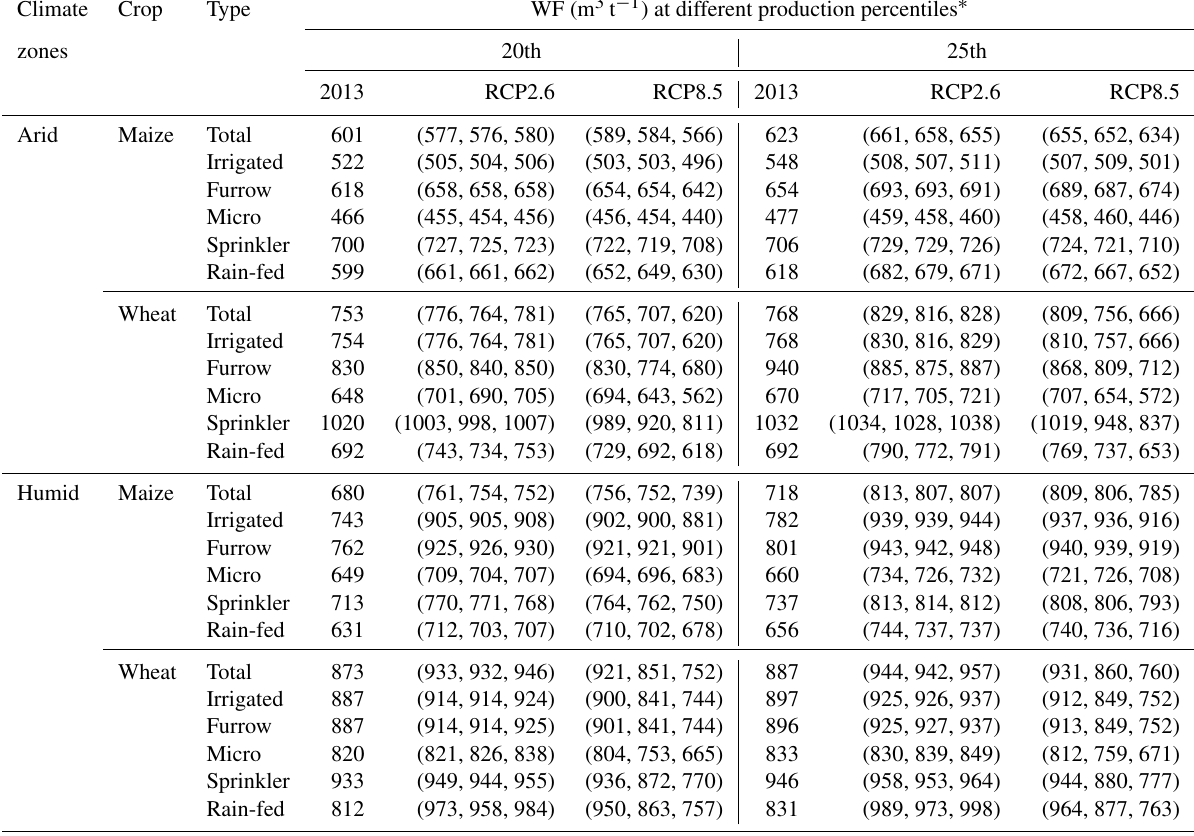
Table 3. The WF benchmarks (m 3 t − 1 ) of maize and wheat for different climate zones (arid and humid) in 2013 as well as future year levels under two climate change scenarios (RCP2.6 and RCP8.5) in